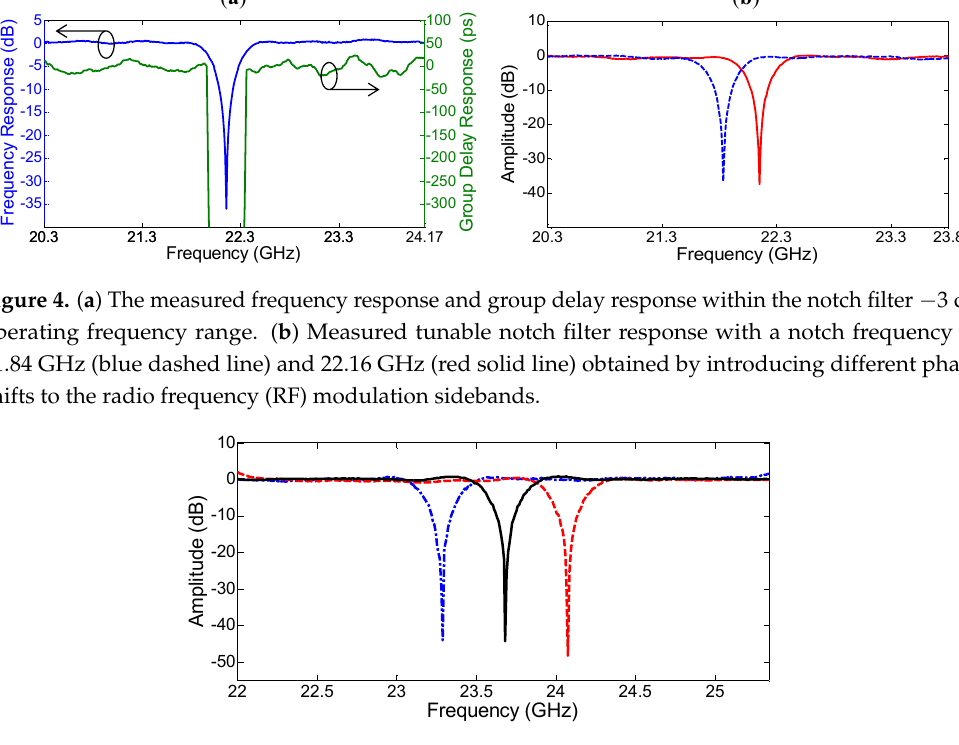
Figure 5. The measured tunable frequency responses of the microwave photonic notch filter with a primary and secondary tap distribution impulse response. The notch frequency is 23.29 GHz (blue dashed-dotted line), 23.68 GHz (black solid line) and 24.05 GHz (red dashed line).